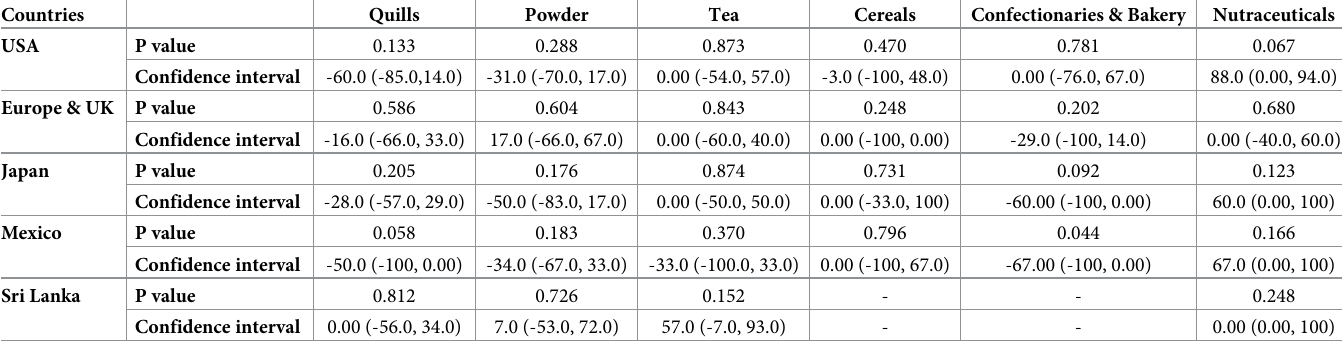
Table 3. Association between present label attributes vs expected label attributes of 6 different cinnamon value-added products. Countries